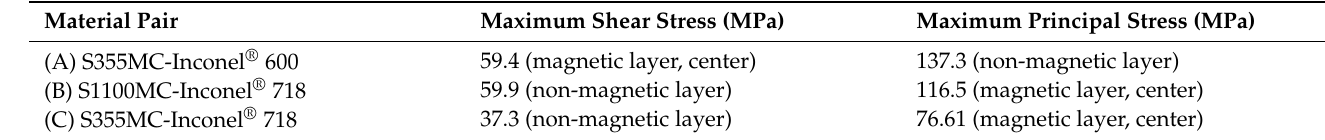
Table 7. Stress results of rotor made of different material